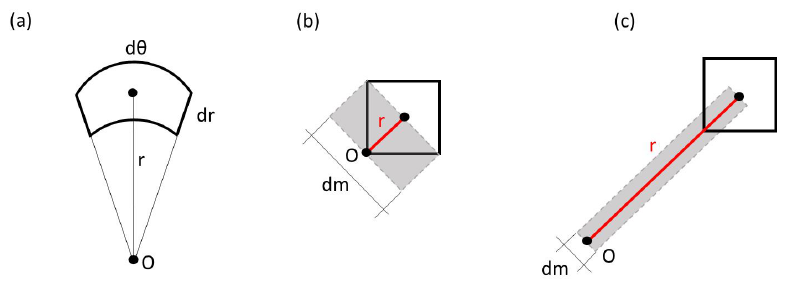
Figure 3. ( a ) Regular grid element of the turbine (typical of VBM applications), ( b ) qualitative representation of a turbine element located near the center O for an irregular grid, and ( c ) qualitative representation of a turbine element located far from the center O for an irregular